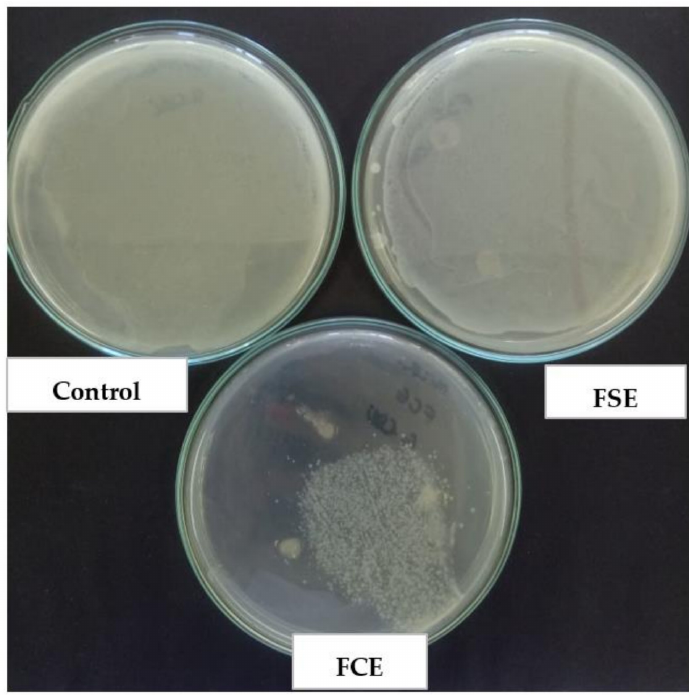
Figure 6. Microatmosphere test in front of Escherichia